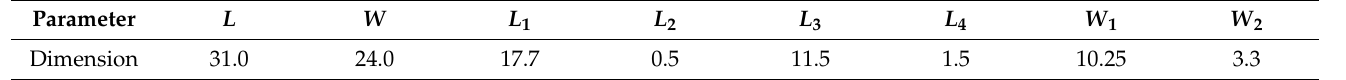
Table 1. Dimensions (mm) of the patch